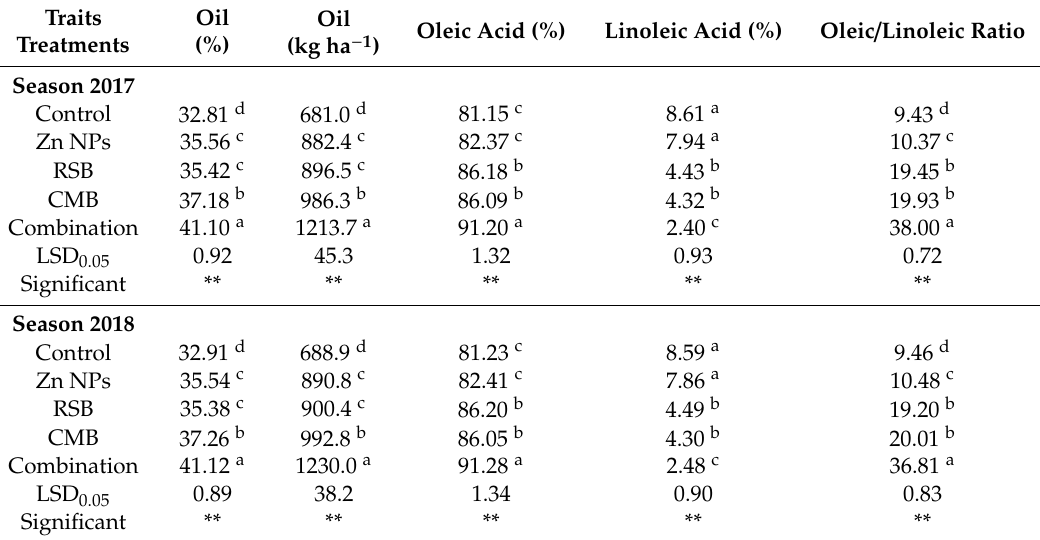
Table 3. E ff ect of zinc nano-particles, plant-biochars, and animal-biochars on oil percentage and its quality of sunflowers grown in soil irrigated with wastewater for the